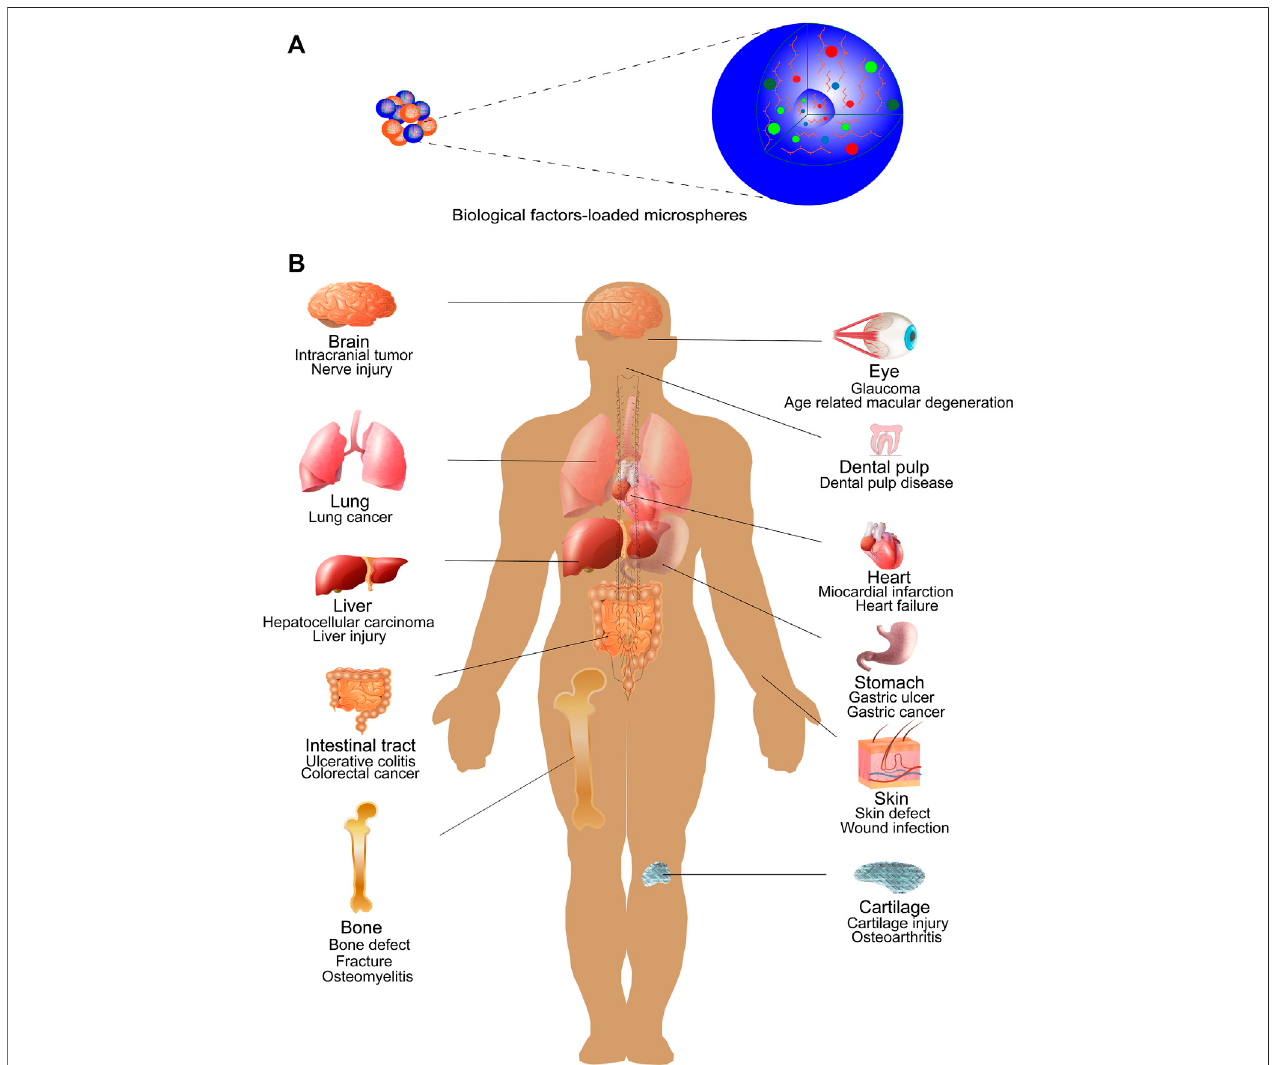
FIGURE 4 | Biomedical applications of microspheres. (A) Microspheres loaded with various biological factors (e.g., growth factors, drugs). (B) Microspheres have been extensively studied and used in biomedical fi elds as delivery and slow release carriers of biologic factors. Studies mainly focus on the repair of various tissue or organ injuries and the treatment of some tumors. Example include bone, cartilage, brain tissue, liver, lung, heart, gastrointestinal tract, eye, skin, dental pulp, etc.